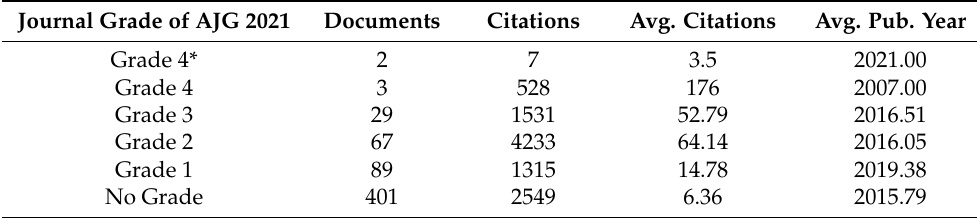
Table 3. The rating of sample studies based on Academic Journal Guide (AJG) 2021.